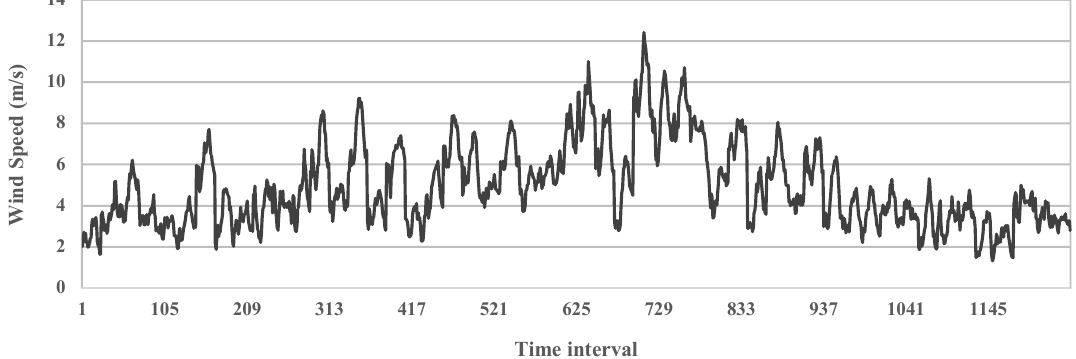
Figure 2. Average wind speed annual data.